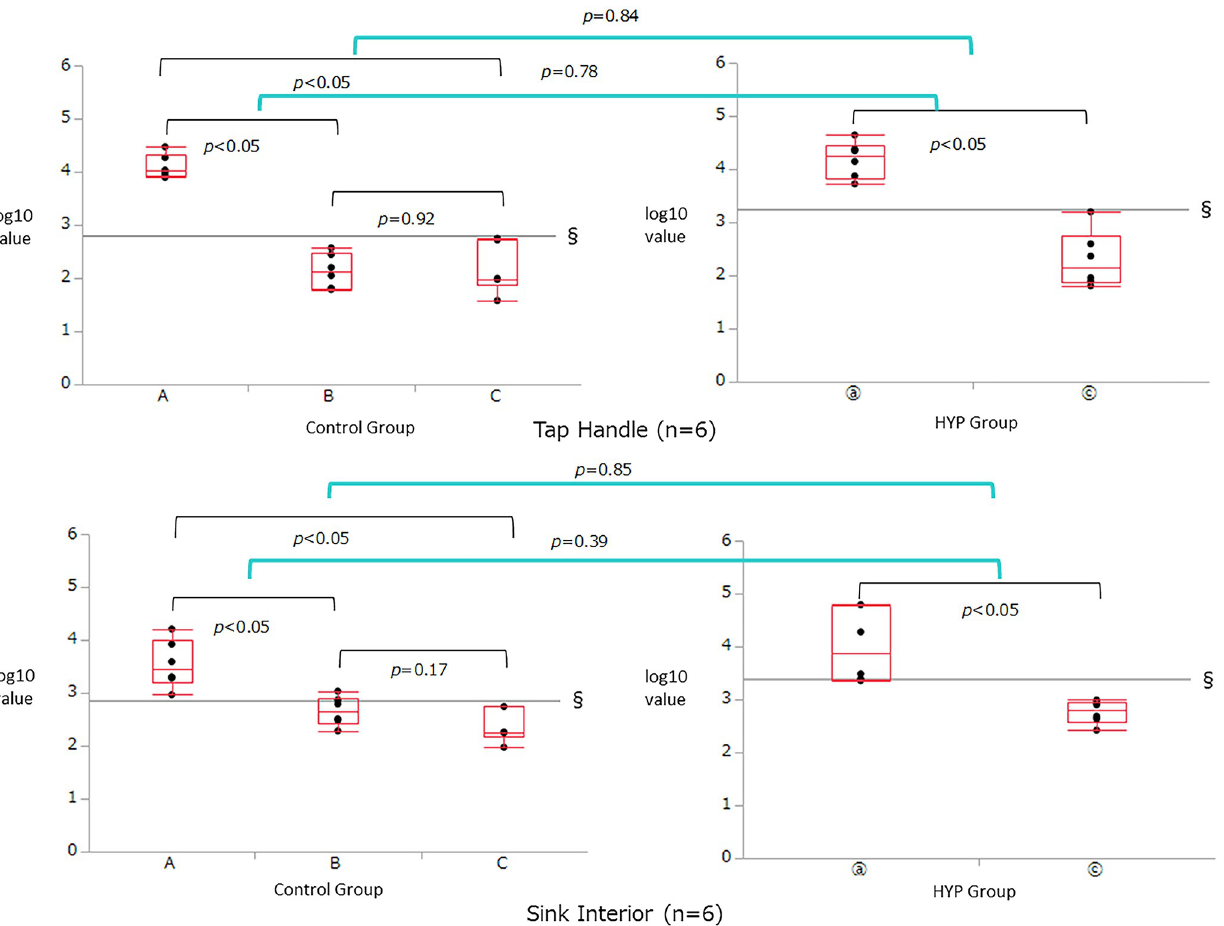
Fig 4. Inter-group comparison of the relative light unit (RLU) and log 10 values in the tap handle and sink test locations measured by adenosine triphosphate (ATP) swab testing. There were significant improvements in the log 10 values of the RLUs from the pre-disinfecting (A) to post-surfactant swab (B) and the post-HYP swab (C) for the control group, and from the pre-disinfecting ( ⓐ ) to post-HYP swab ( ⓒ ) for the HYP group ( p < 0.05). There were no significant differences in the log 10 values of the RLUs between the post-surfactant swab (B) and post-HYP swab (C) for the control group at the tap handle and sink ( p = 0.92, Fig 4 top; p = 0.17, Fig 4 bottom). In both these locations, there were no significant differences in the change in log 10 values of the RLUs between the post-HYP swab ( ⓒ ) of the HYP group and the post-surfactant swab (B) and post-HYP swab (C) of the control group.